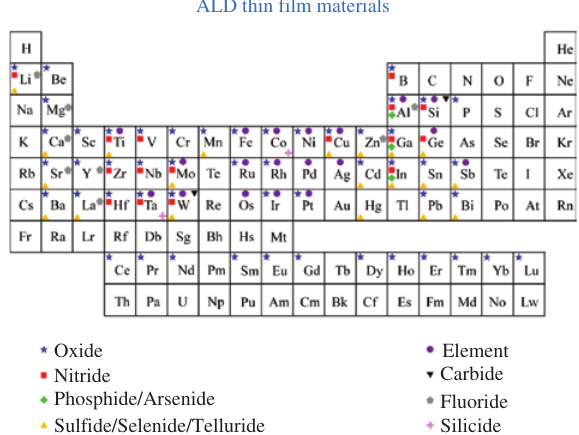
Figure 3: Overview of elements used for ALD materials. Reprinted with permission from Ref. [30]. Copyright 2016 Elsevier